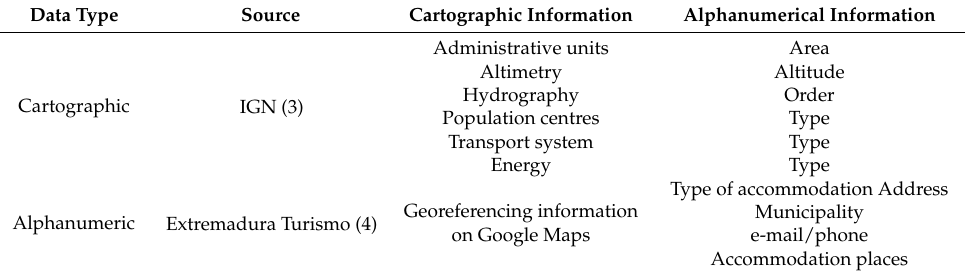
Table 1. Geographical information system (GIS)